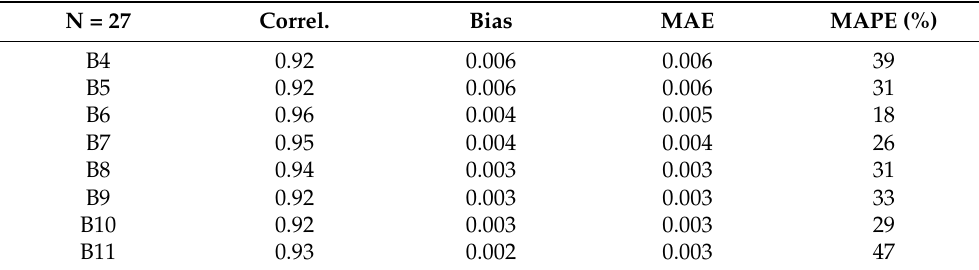
Table 4. Statistical indicators between the measured and satellite-derived (OLCI) water reflectances using the 6SV